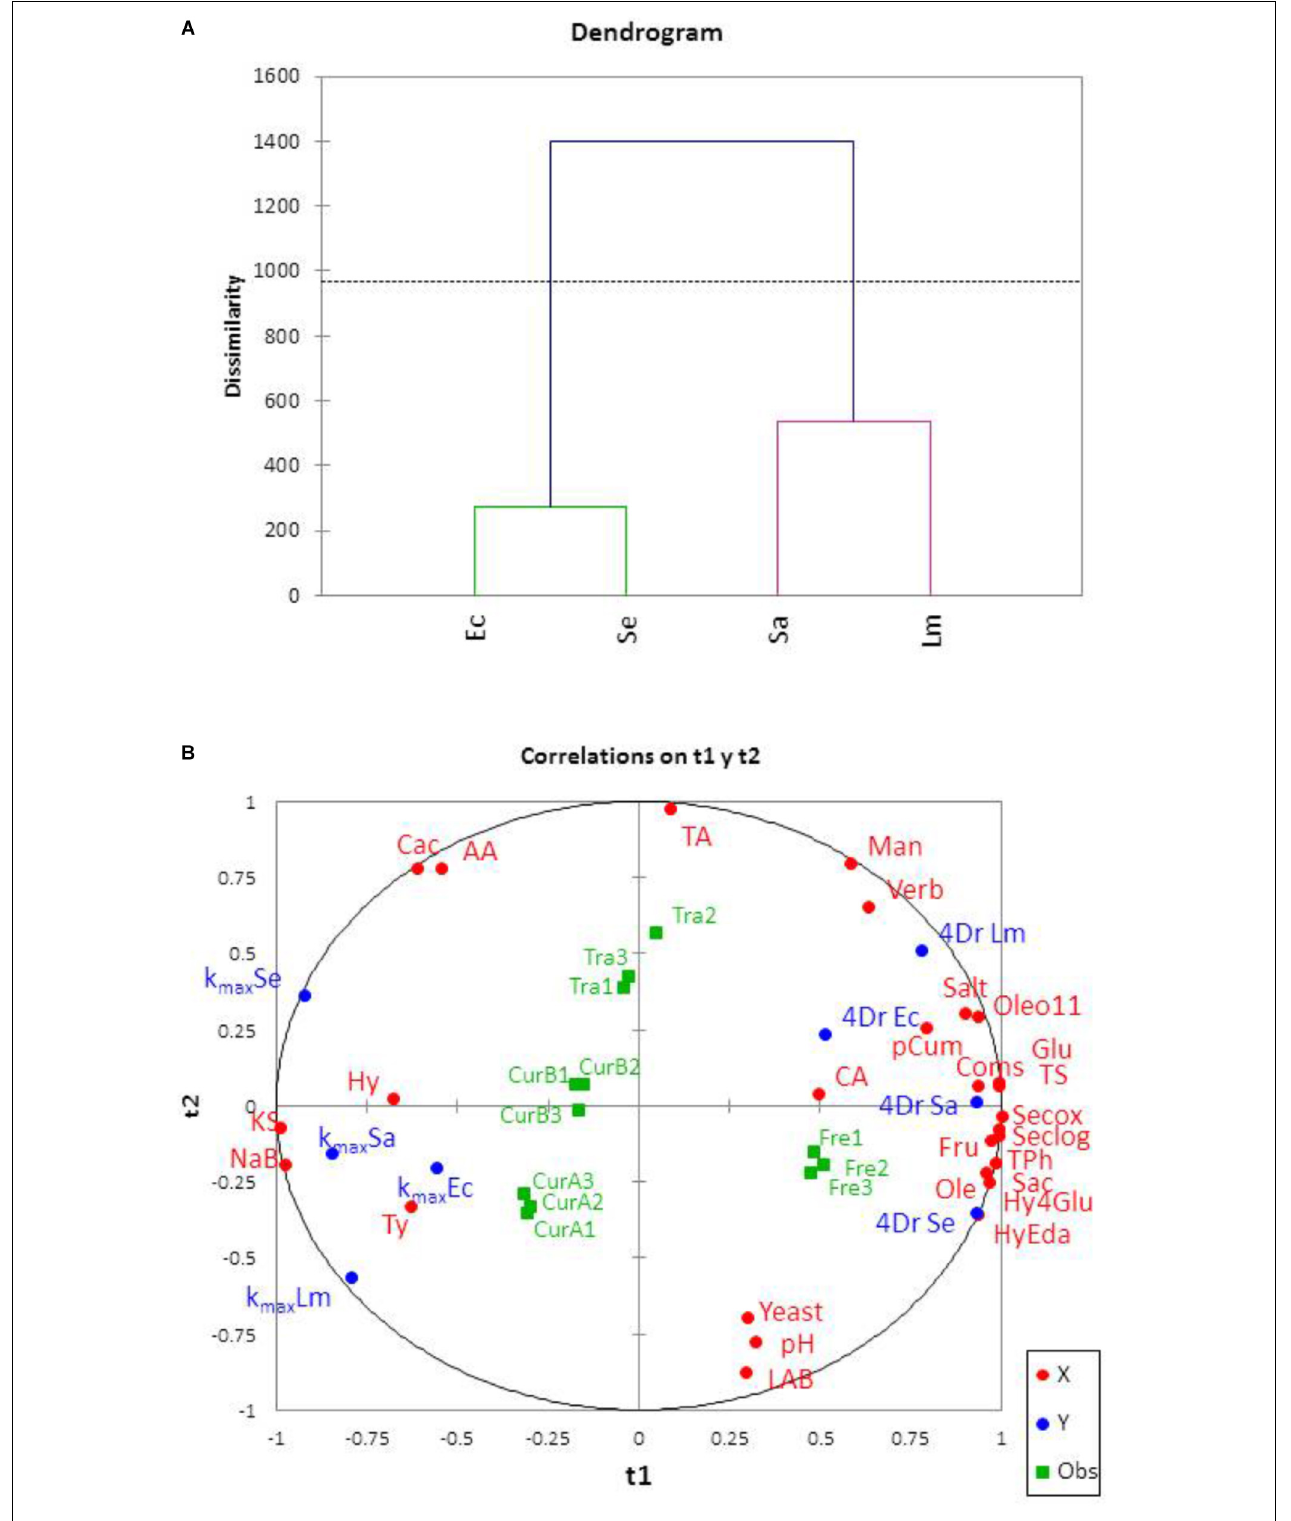
FIGURE 4 | Cluster analysis of pathogen’s behavior based on the fit parameters (A) and correlation wheel of the variables studied on the plane of the first two PLS components (B) . 4Dr , time in hours for a reduction of 4 log 10 from N 0 ; kmax, maximum death rate (h - 1 ); Ec, Sa, Lm, and Se stand for the different cocktails assayed, E. coli, S. aureus, L. monocytogenes, and S. enterica, respectively. LAB, lactic acid bacteria. See Table 1 for the meaning of the rest of abbreviations.